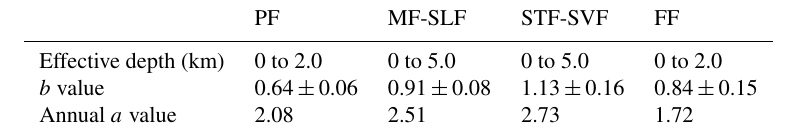
Table 2. Effective depth, b and a coefficients of the GR relationship for each SZ, obtained from the instrumental earthquake dataset (2005– 2015).